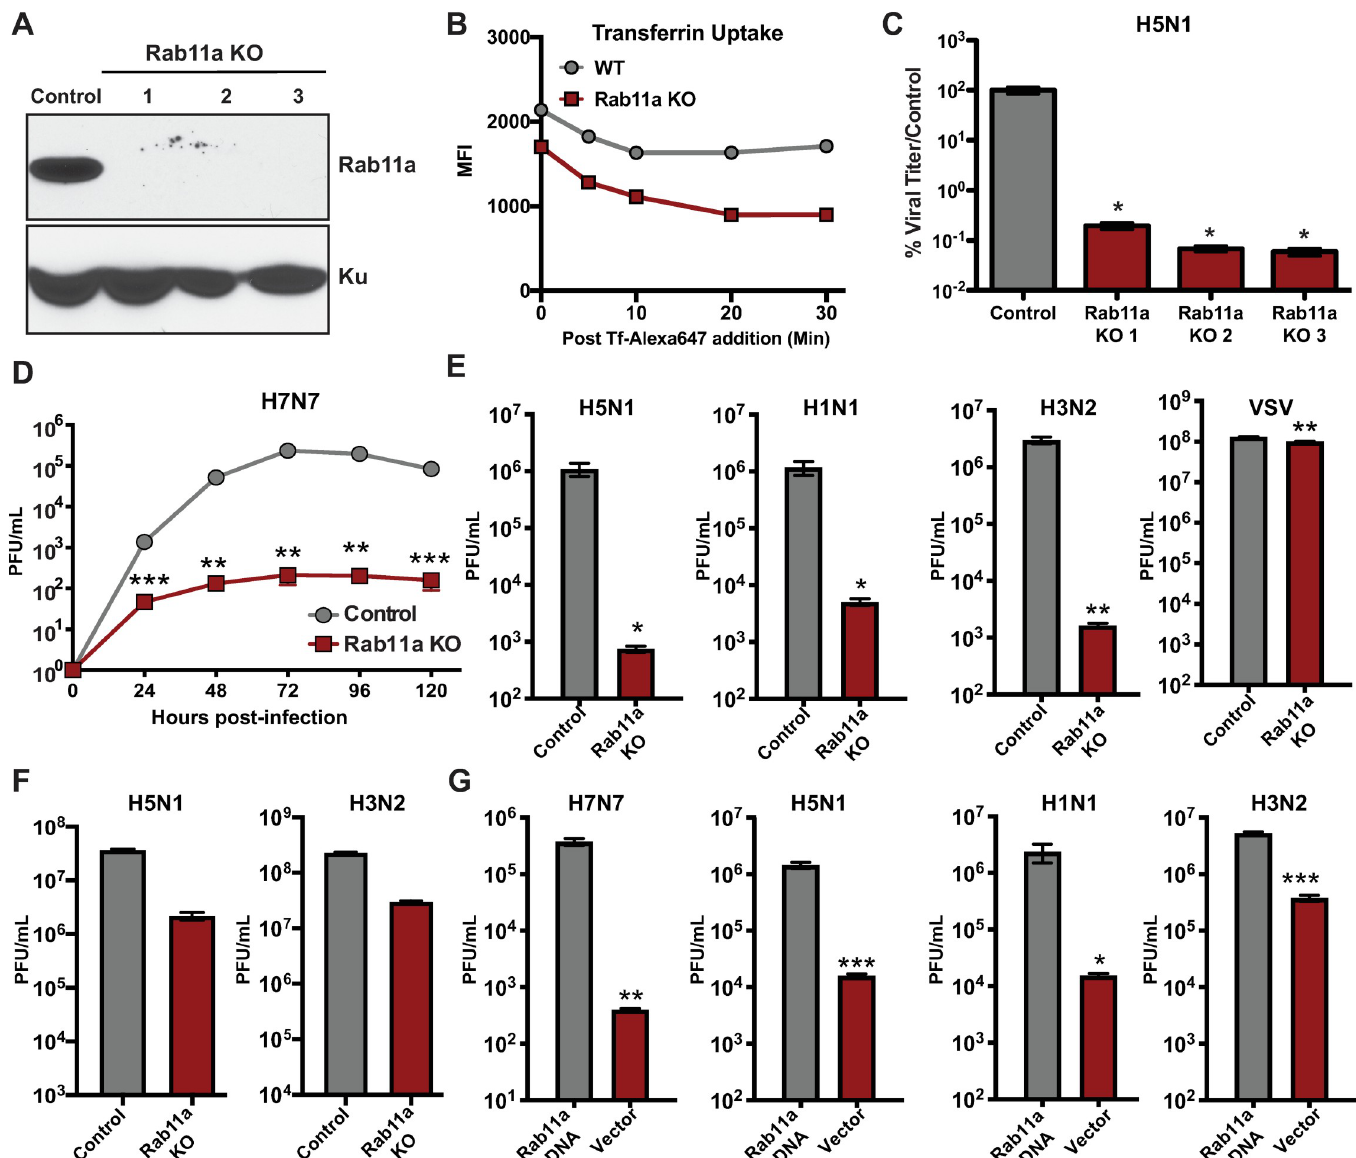
Fig 3. Rab11a is essential for the replication of multiple IAV strains. (A) Western blot analysis of Rab11a expression in control and Rab11a KO A549 cells. Cell lysates from control A549 cells and three independent clones of Rab11a KO cells were subjected to western blot analysis for Rab11a expression. Ku expression was used as a loading control. (B) Rab11a KO cells show reduced transferrin uptake. Serum starved control A549 and Rab11a KO cells were incubated with labelled transferrin for 20 min and transferrin levels at the indicated times were measured by flow cytometry. Values are shown as mean fluorescent intensity (MFI). (C) H5N1 replication is reduced in Rab11a KO cells. Control A549 cells and Rab11a KO cells were infected with H5N1 (MOI = 0.001) and viral titers were measured at 48 hpi by plaque assay. Viral titers are shown as mean % relative to titer from control cells ± SD. (D) H7N7 shows decreased replication kinetics in Rab11a KO cells. Control A549 and Rab11a KO cells were infected with H7N7 (MOI = 0.01) and viral titers were measured at the indicated time points. (E) Replication of different IAV strains is reduced in Rab11a KO cells. Control A549 and Rab11a KO cells were infected with H5N1 (MOI = 0.001), H1N1 (MOI = 0.01), H3N2 (MOI = 0.01), and VSV (MOI = 0.001) and viral titers were measured at 48 hpi by plaque assay. (F) Single cycle replication of different IAV strains in Rab11a KO cells. Control A549 and Rab11a KO cells were infected with H5N1 (MOI = 1), and H3N2 (MOI = 5), and viral titers were measured at 24 hpi by plaque assay. (G) Complementation of Rab11a expression in Rab11a KO cells restores IAV replication. Rab11a KO cells complemented with empty vector or Rab11a cDNA were infected with H5N1 (MOI = 0.001), H1N1 (MOI = 0.01), and H7N7 (MOI = 0.01) and viral titers were measured at 48 hpi. For panels C-E, the limit of detection = 10 PFU. Data are represented as mean titer of triplicate samples ± SD. � p- value < 0.05; �� p-value < 0.01; ��� p-value < 0.001; ns, non-significant. Data are representative of at least three independent